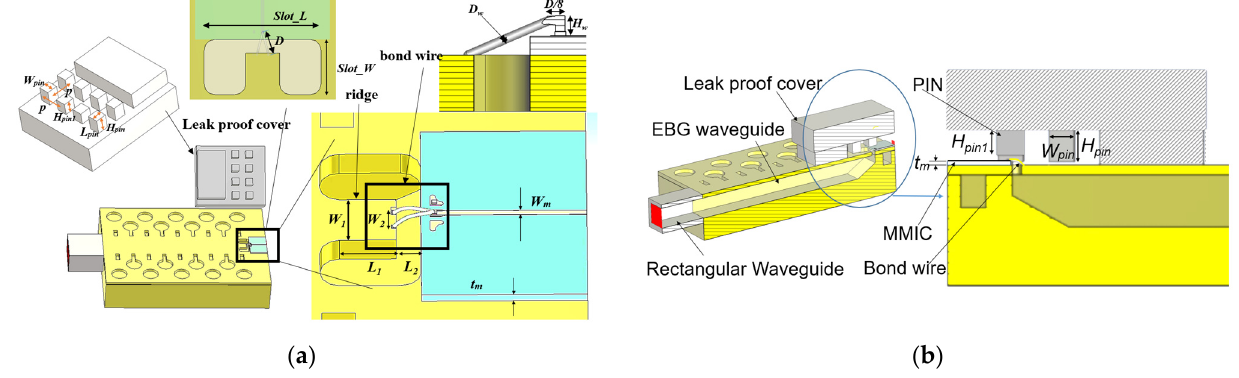
Figure 6. Proposed chip-to-waveguide transition: ( a ) the top-down view of the transition and the associated important dimension parameters; ( b ) the perspective view, split in half.